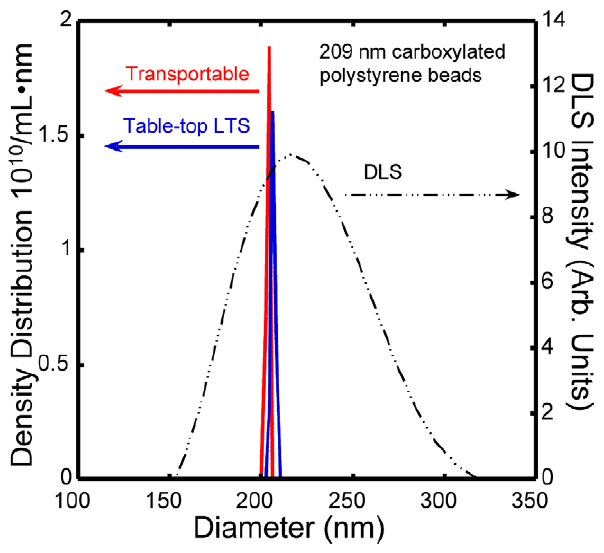
Figure 2. Comparison between LTS and DLS results. The plot shows the particle size distributions obtained for 209 nm carboxylated polystyrene beads in water using: the original table-top LTS apparatus (solid blue line); a transportable LTS based instrument (solid red line); and a commercial DLS based instrument (dash-dot-dot-dot line).